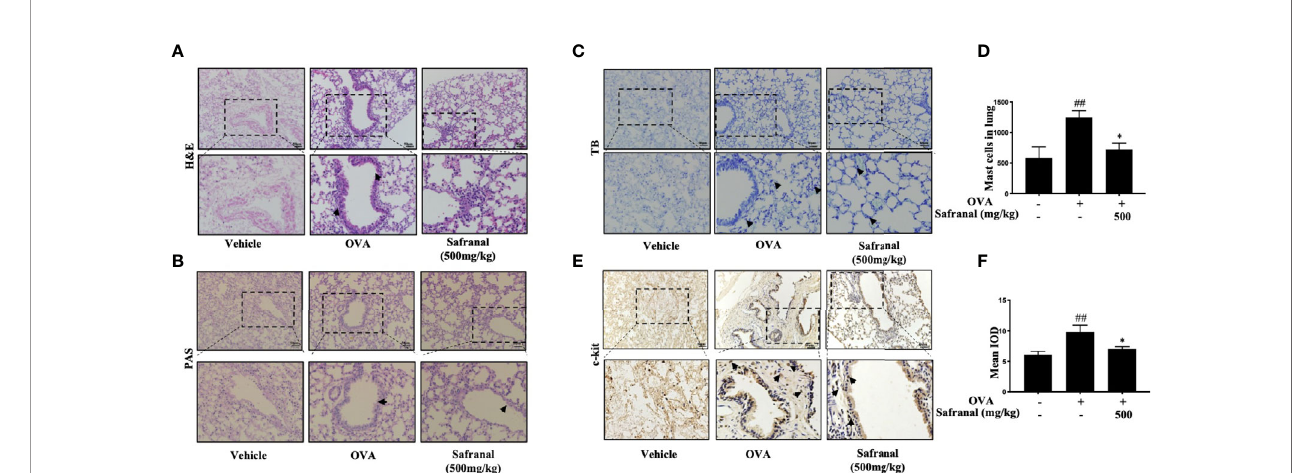
FIGURE 2 | Histological of lung tissue. (A, B) H&E and PAS staining showed safranal suppressed in fi ltration of in fl ammatory cells, amount of mucus secretion. (C, D) Toluidine blue staining of lung tissue showed the number of mast cell in lung tissue. Numbers of mast cells within the lung were quanti fi ed in 200×200µm. (E, F) IHC staining of c-kit showed marker of the mast cells. The data are presented as the means ± S.E.M. of n=10. ## p <0.01 compared to nontreated group. * p <0.05 compared to OVA treated group. The scale labels shown are 50 m m.